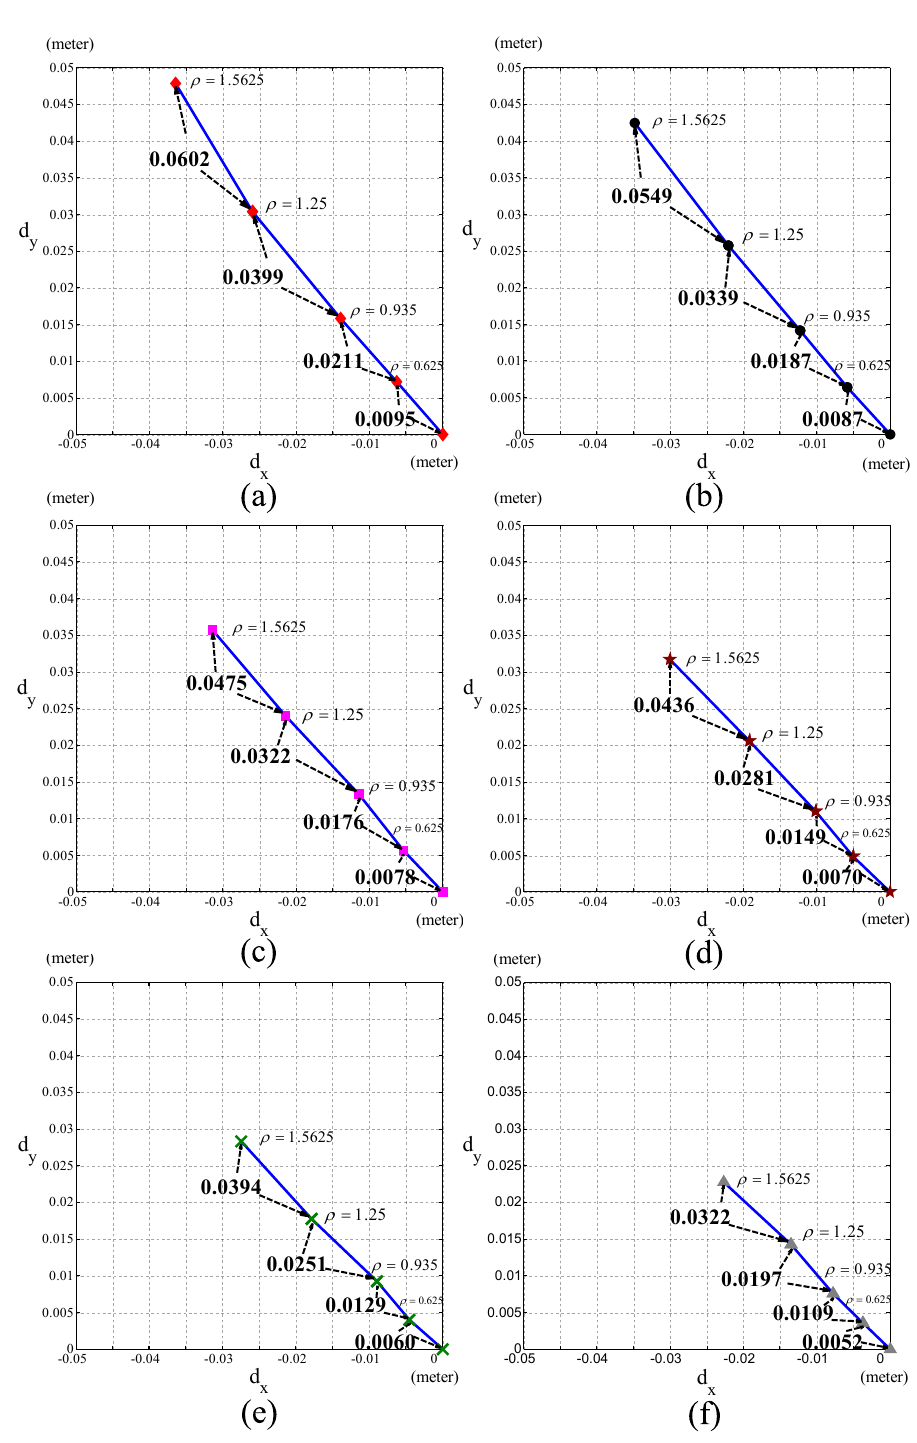
Figure 10. Experimental results of the Cartesian position errors of the end-effector caused by the fixed (cid:52) m and the changes of the joint velocities ( ρ ). ( a ) (cid:52) m = − 3% ; ( b ) (cid:52) m = − 2%